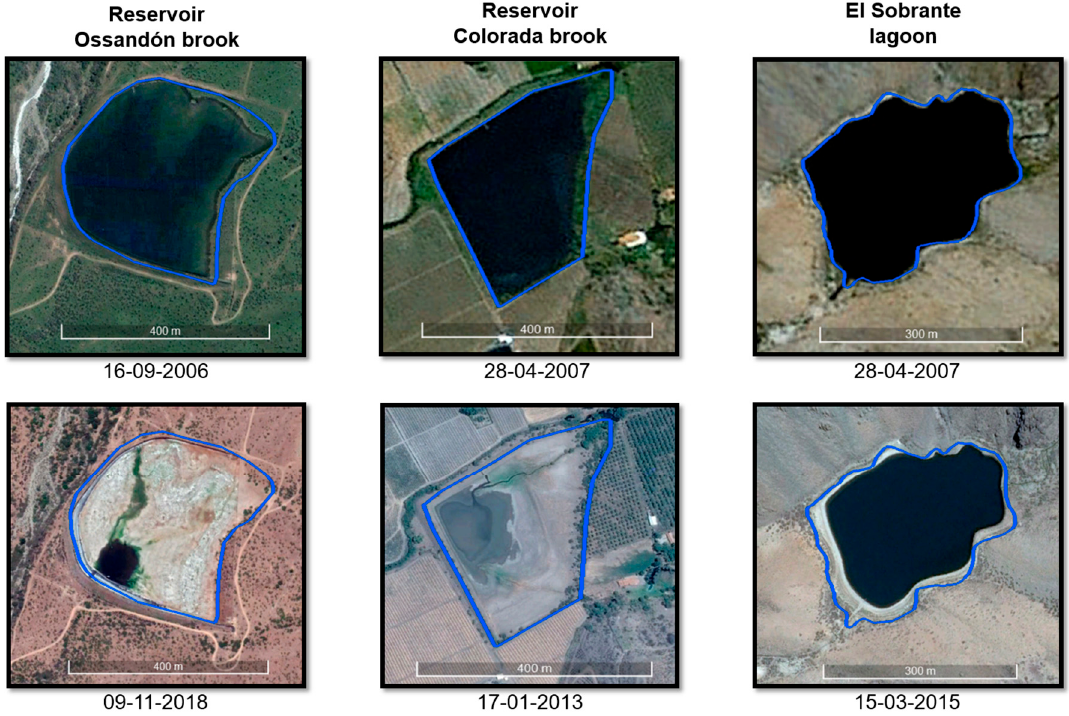
Figure A2. Examples of the dramatic fluctuations in area for the main water bodies of the Petorca basin. Source: Google Earth